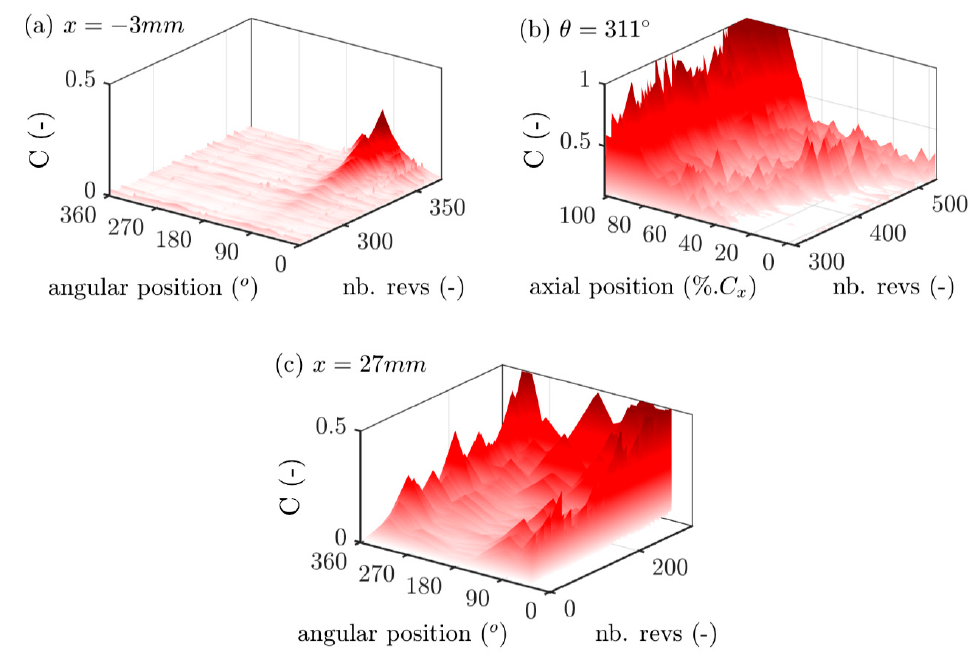
Figure 11. Correlation evolution during a throttling process. ( a ) For different angular positions, − 0.06C x upstream of the LE; ( b ) for different axial positions at θ = 311°; ( c ) different angular positions, 0.55Cx downstream of the LE.